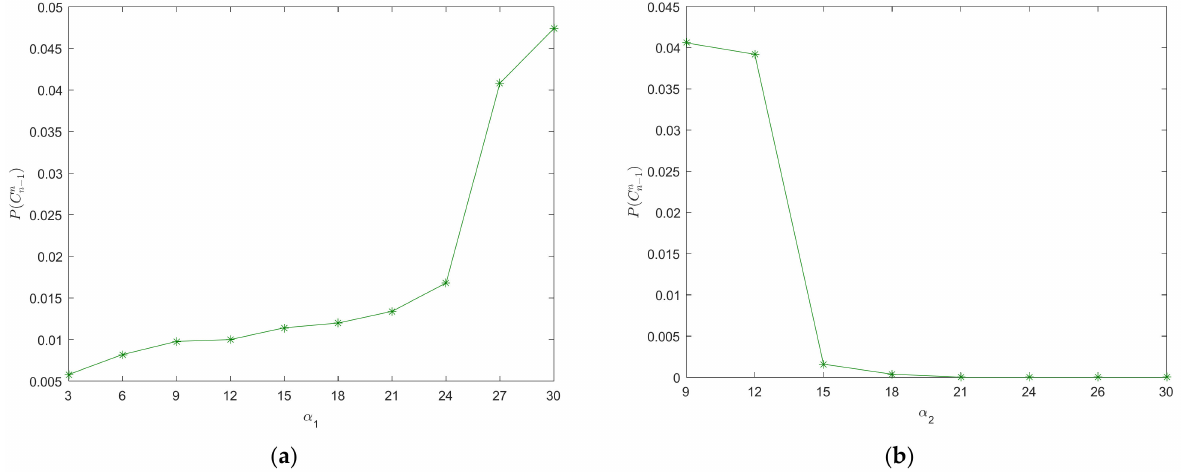
Figure 6. Varying of REC probability with the acceleration and deceleration preference coefficients, ( a ) acceleration preference coefficient; ( b ) deceleration preference